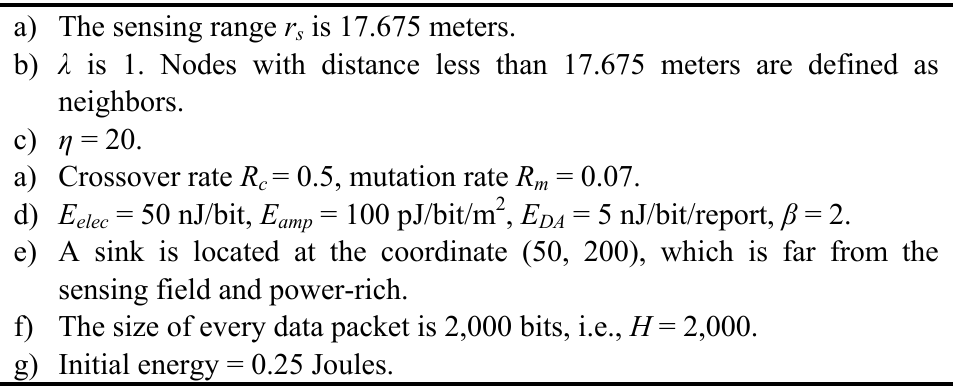
Table 2. Parameters used in the CWSN-type sample